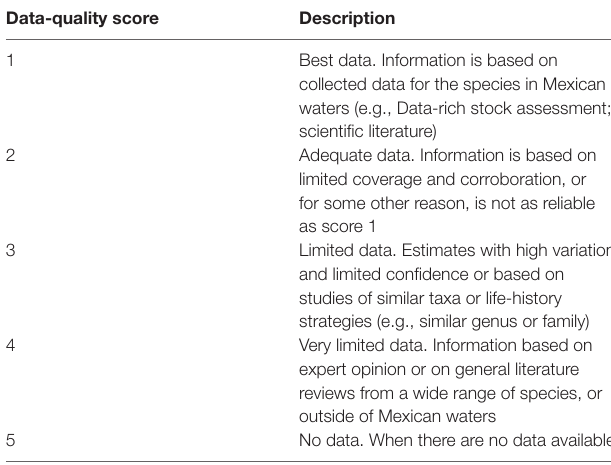
TABLE 2 | Description of scores used in data quality evaluation (Modified from Patrick et al.,